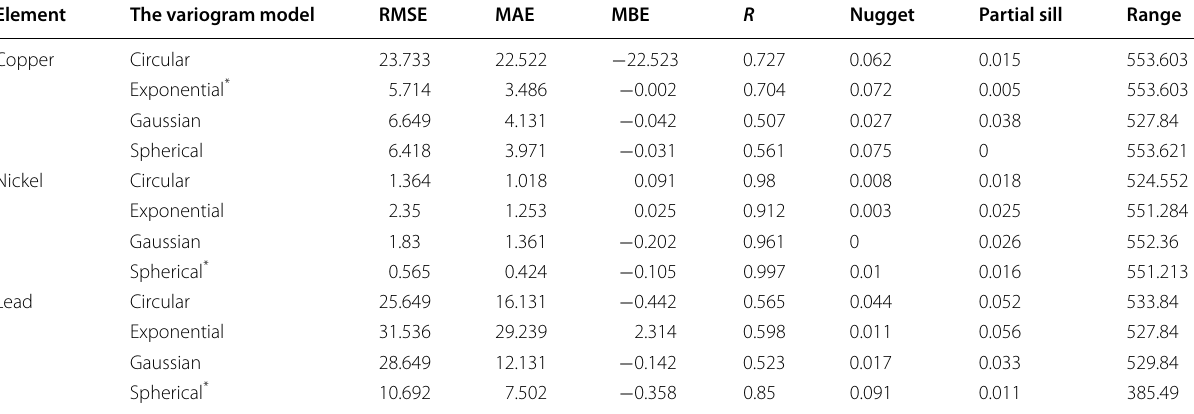
The models were selected with regard to minimum RMSE, MAE, MBE, and maximum R from Table 5.